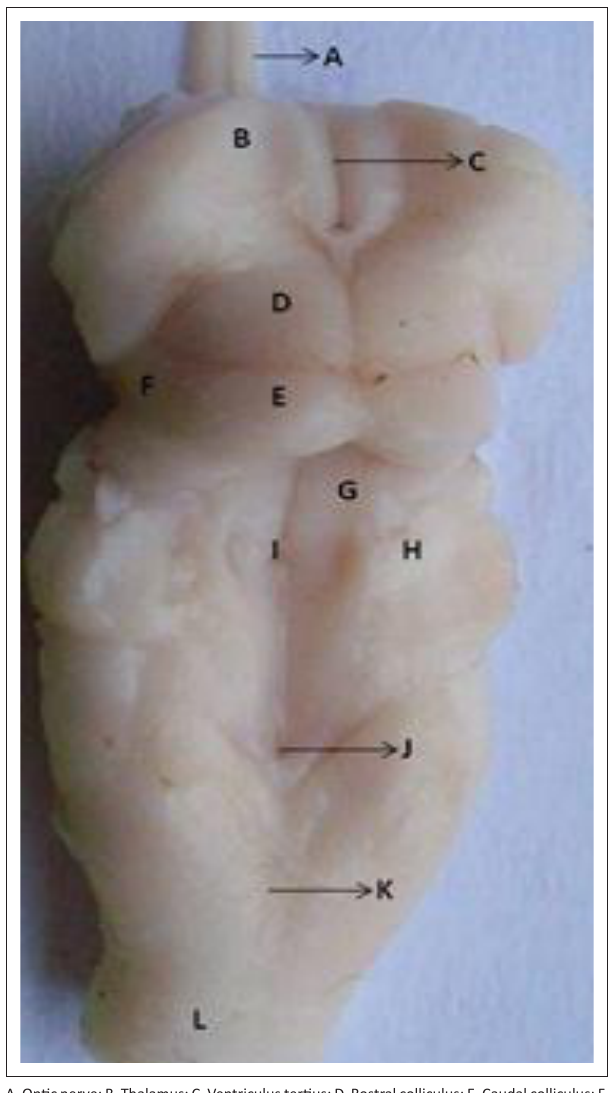
(Figure 3: B and C). Caudal to the thalamus and lateral to the rostral colliculus was a small protuberance, the lateral geniculate body. The caudal border of the thalamus was wider than the rostral border, thus overlapping the rostral colliculus and occluding the lateral geniculate body from the dorsal view of the brainstem (Figure 3). The rostral colliculus was continuous with the lateral geniculate body through its brachium. Below the lateral geniculate body and lateral to the caudal colliculus was the medial geniculate body (Figure 3: F). The caudal colliculus was also continuous bilaterally with the medial geniculate body through its brachium. However, the brachia were not clearly visible. The lateral geniculate body was apparently more distinct than the medial geniculate body. The geniculate bodies made up the metathalamus of the diencephalon. The pineal gland (part of the epithalamus) was very small in the African giant pouched rat.